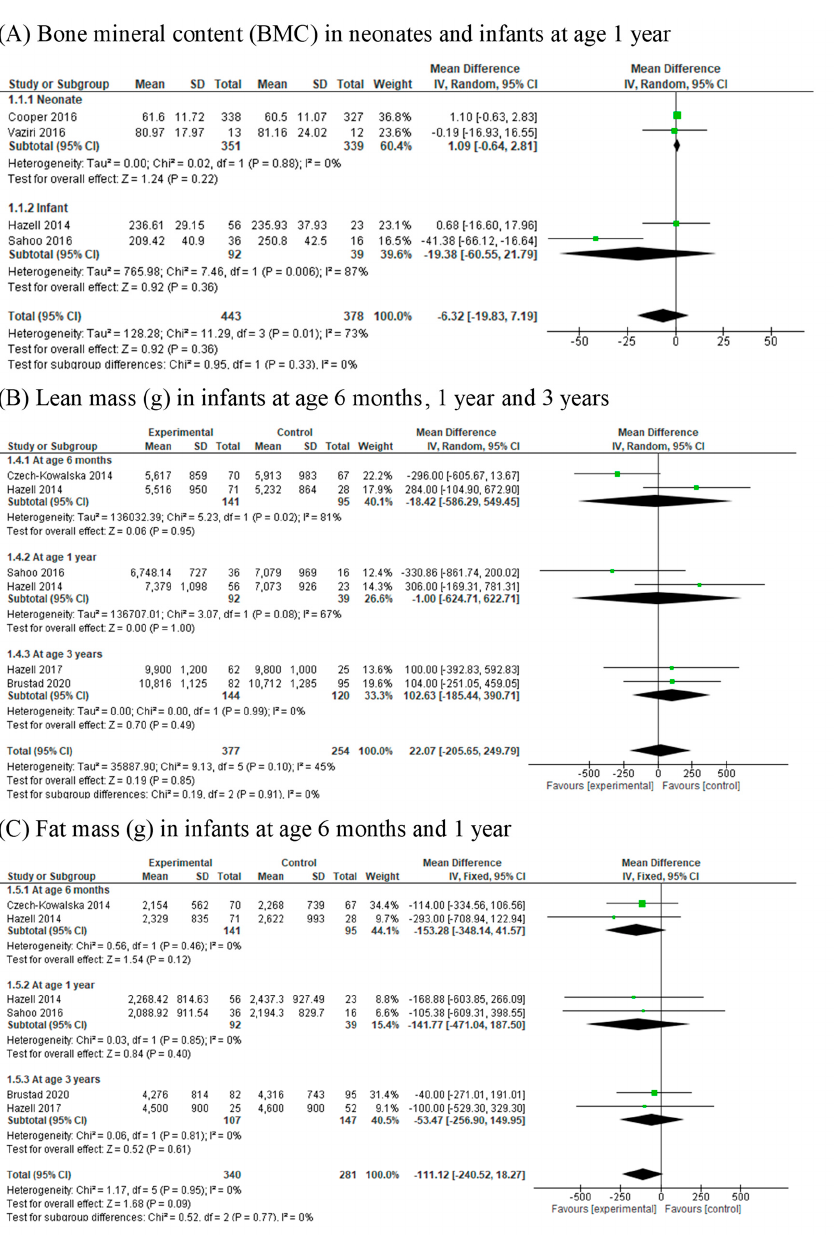
Figure 2. Forest plots of summary crude risk ratios of the association between vitamin D supplementation in early life and childhood body composition (( A ) Bone mineral content; ( B ) Lean mass; ( C ) Fat mass).